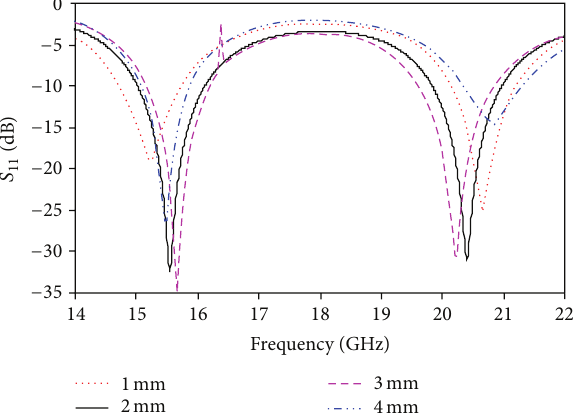
Figure 5: Simulated return loss for different values of 𝑅